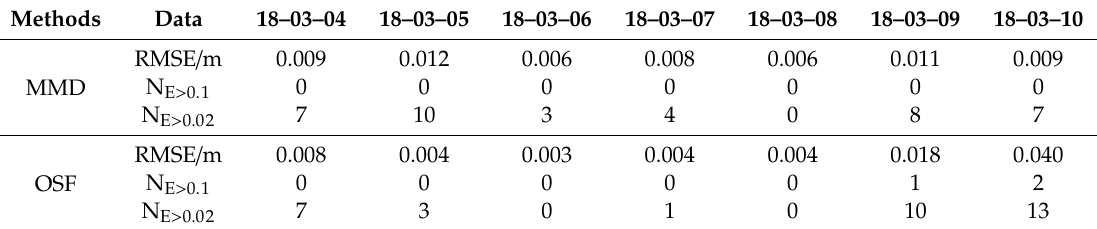
Table 5. RMSEs and numbers of error measurements of the MMD and OSF methods.